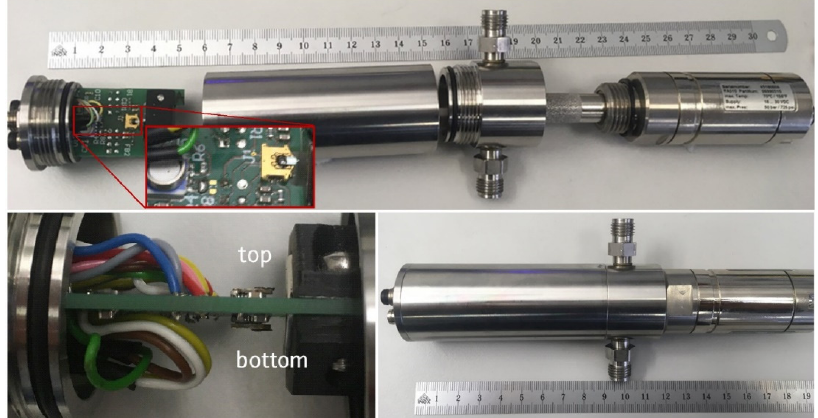
Figure 2. Top : General view of the measuring chamber with sensor printed circuit board (PCB), gas cylindrical chamber with inner diameter of 30 mm, fluidic connections and dew point sensor. Zoom : top view of the sensor PCB with the pressure and temperature sensor [11] and a first microcantilever in front of a permanent magnet. Bottom left : the second cantilever is placed on the backside of the PCB. Actuation occurs by supplying a small alternating current (AC) intensity over the metal coil on the cantilever tip. Bottom right : sensor PCB and dew point sensor mounted in a pressure tight measuring chamber (numbers in the scale correspond to cm).